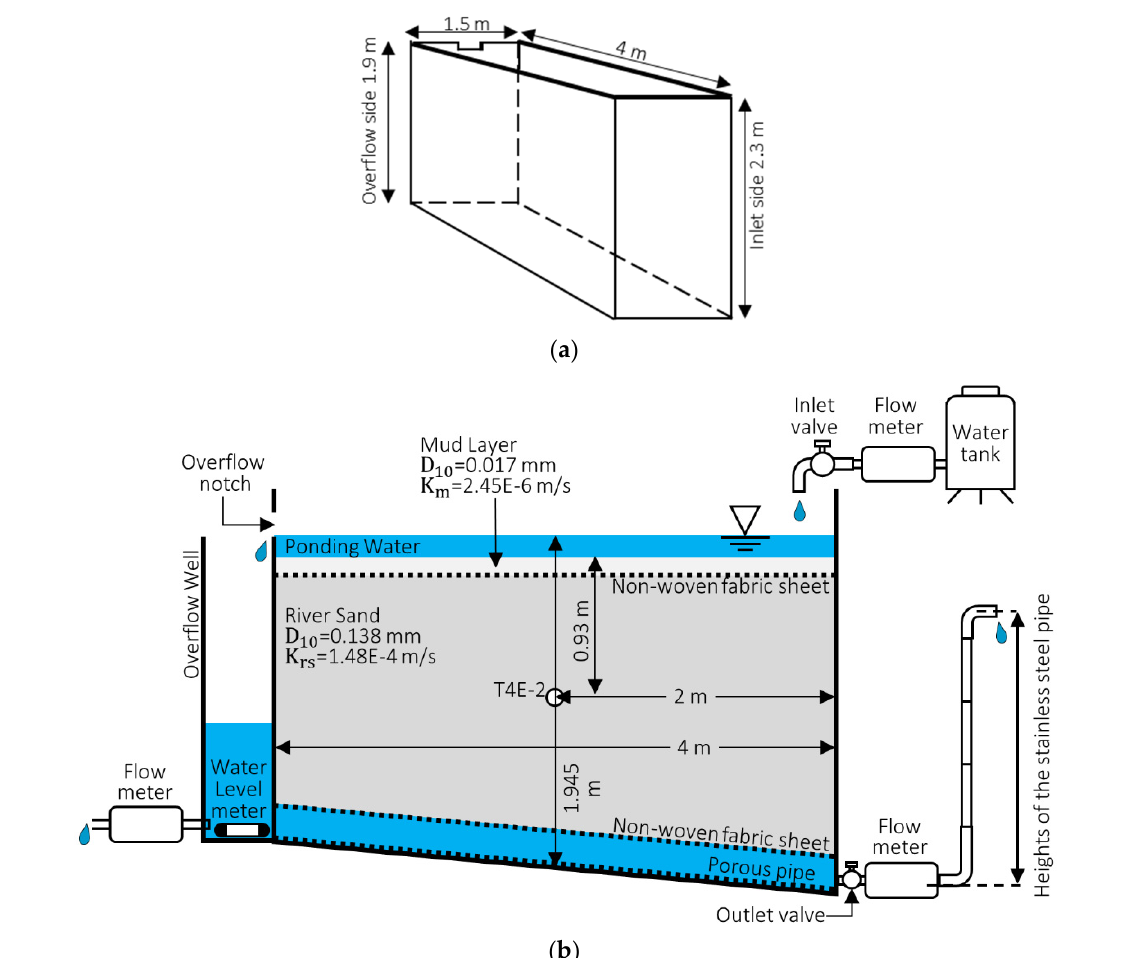
Figure 3. A schematic diagram of the lysimeter. ( a ) Perspective view. ( b ) Section view and the equipment set.